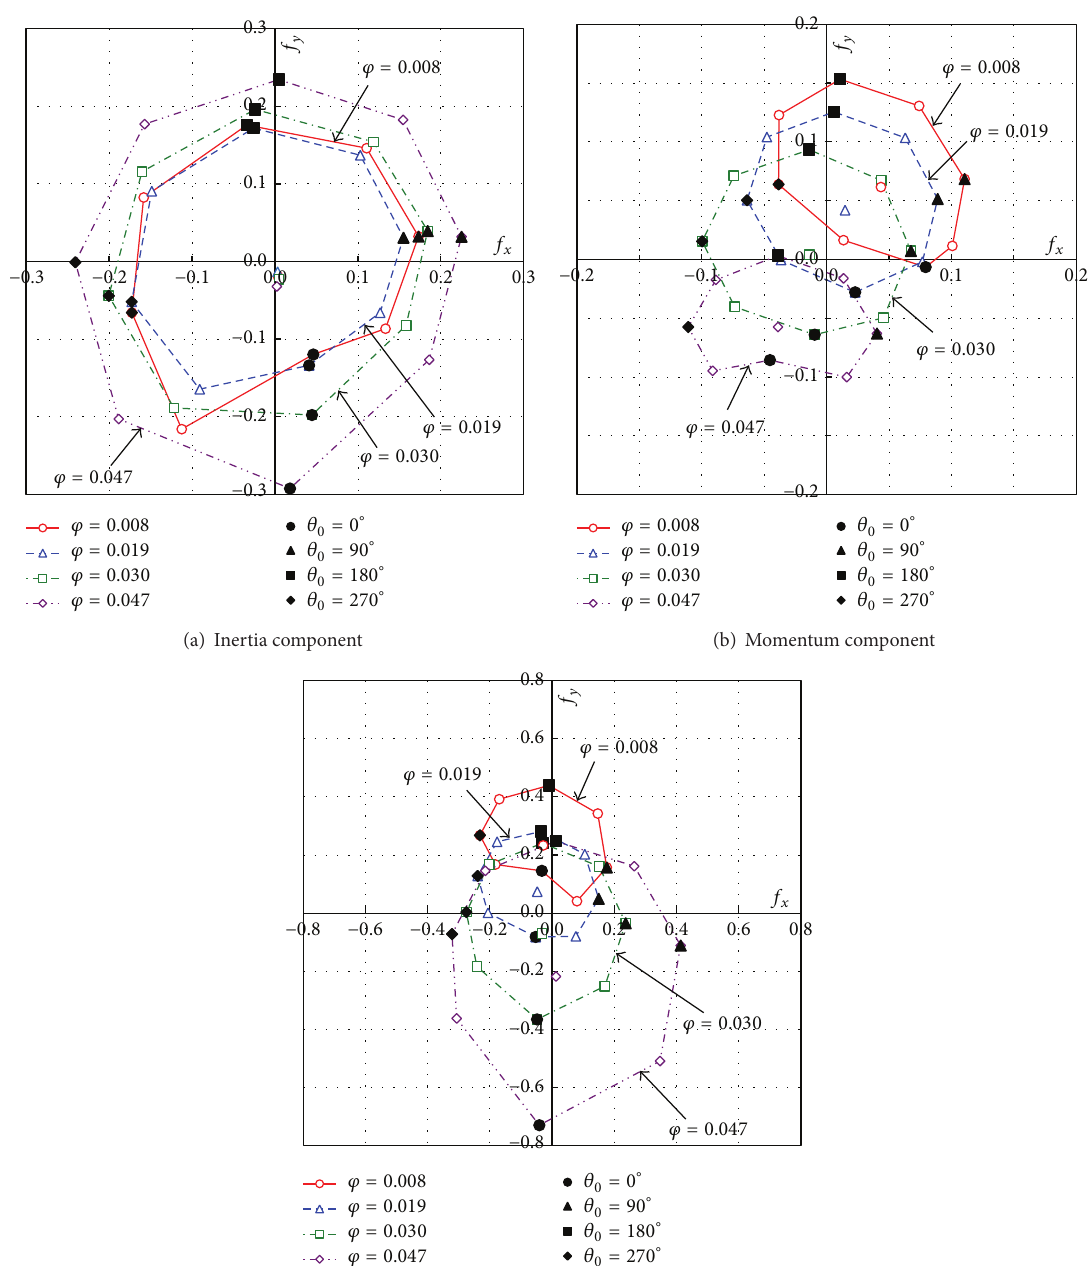
Figure 11: Lissajous figures of each component of radial thrust coefficient ( 𝛽 𝑏2 = 24